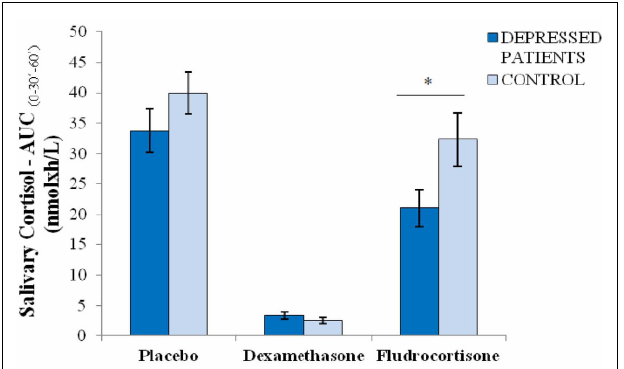
FIGURE 2 | Cortisol awakening response (measured as area under the curve) after placebo, dexamethasone (GR agonist), and fludrocortisone (MR agonist) in 20 depressed patients and 10 healthy controls; * p < 0.05 . Note: AUCg (0–30 (cid:48) –60 (cid:48) ) = Area under the curve from salivary cortisol immediately upon awakening, 30 and 60min later (nmol × h/L); values are means, with standard errors represented by vertical bars.